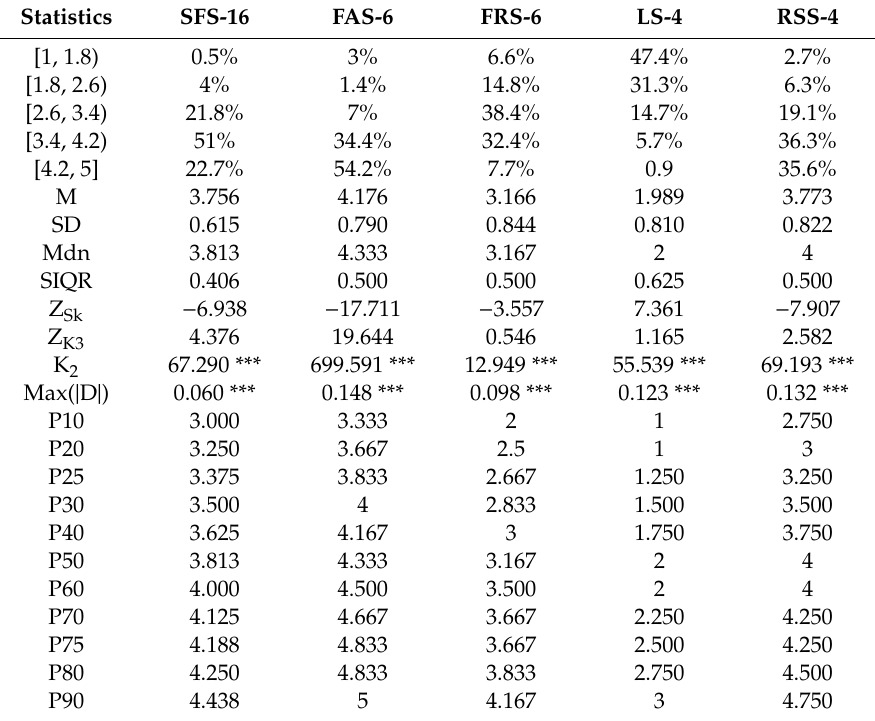
Table 5. Descriptive statistics and normality